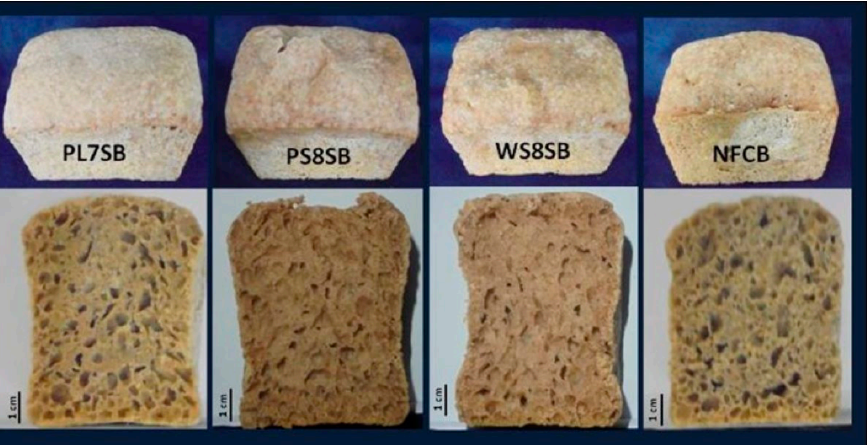
Figure 1. Photographs of sourdough breads (SB) and crumbs obtained with different LAB strains and control bread: PL7SB (SB with Pediococcus pentosaceus LD7); PS8SB (SB with Pediococcus pentosaceus SA8); WS8SB (SB with Weissella confusa SD8), NFCB (control bread without